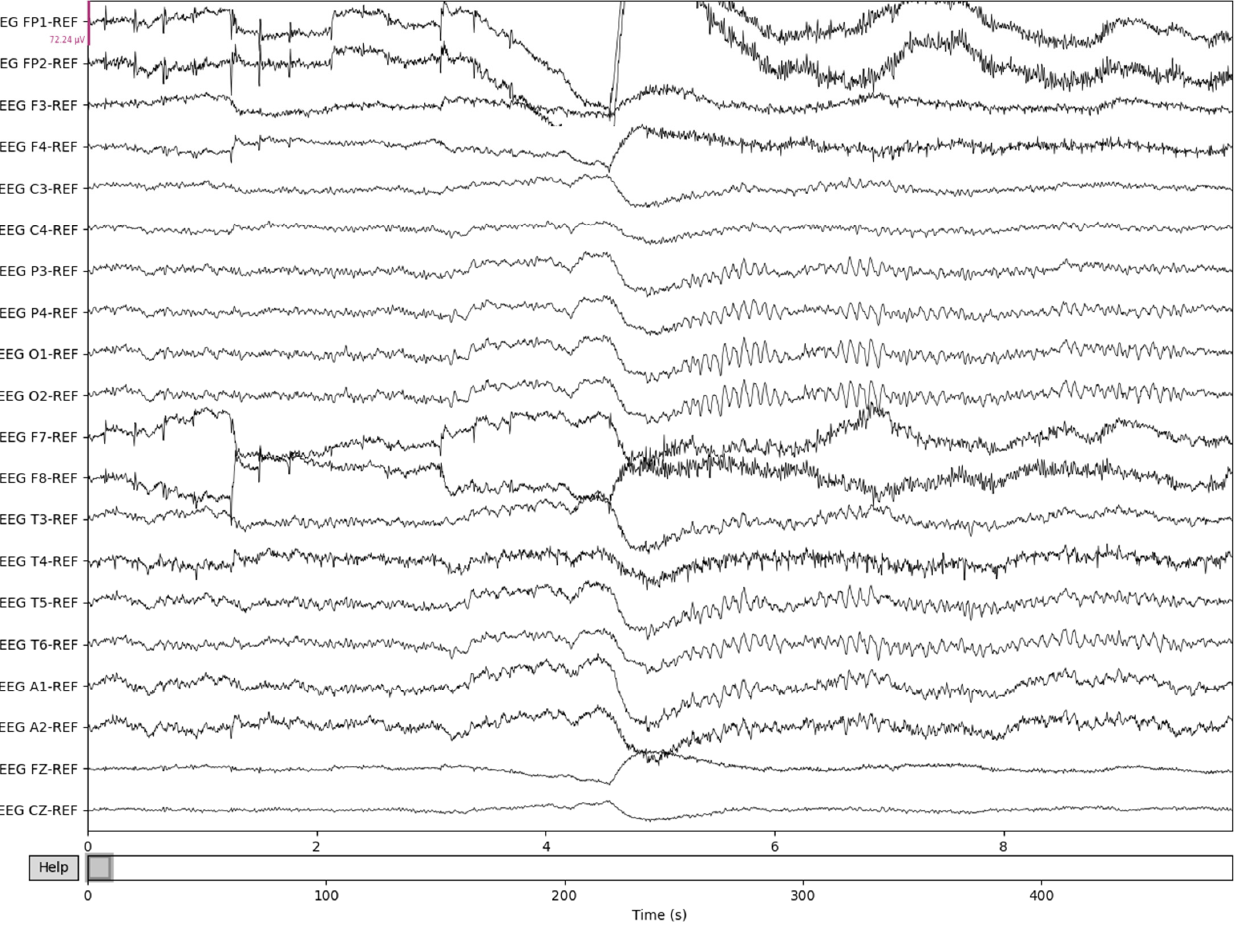
Figure 5. Post-cropping and resampling visualization of the EEG recordings.